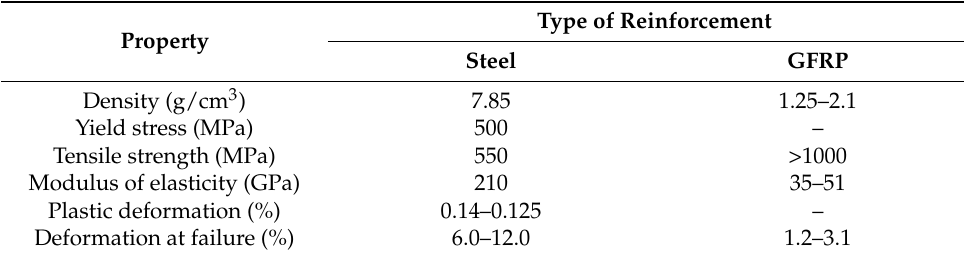
Table 2. Mechanical and physical properties of used reinforcement.